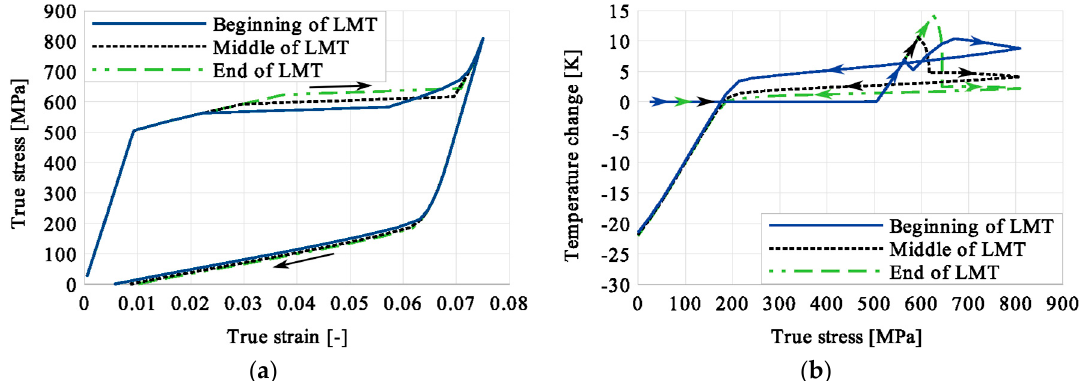
Figure 18. Comparison of numerical results obtained for TiNi SMA tension with 3-min loading interruption induced at the beginning (Program 1), middle (Program 2) and end (Program 3) of the LMT: ( a ) stress vs. strain; ( b ) temperature change vs. stress.